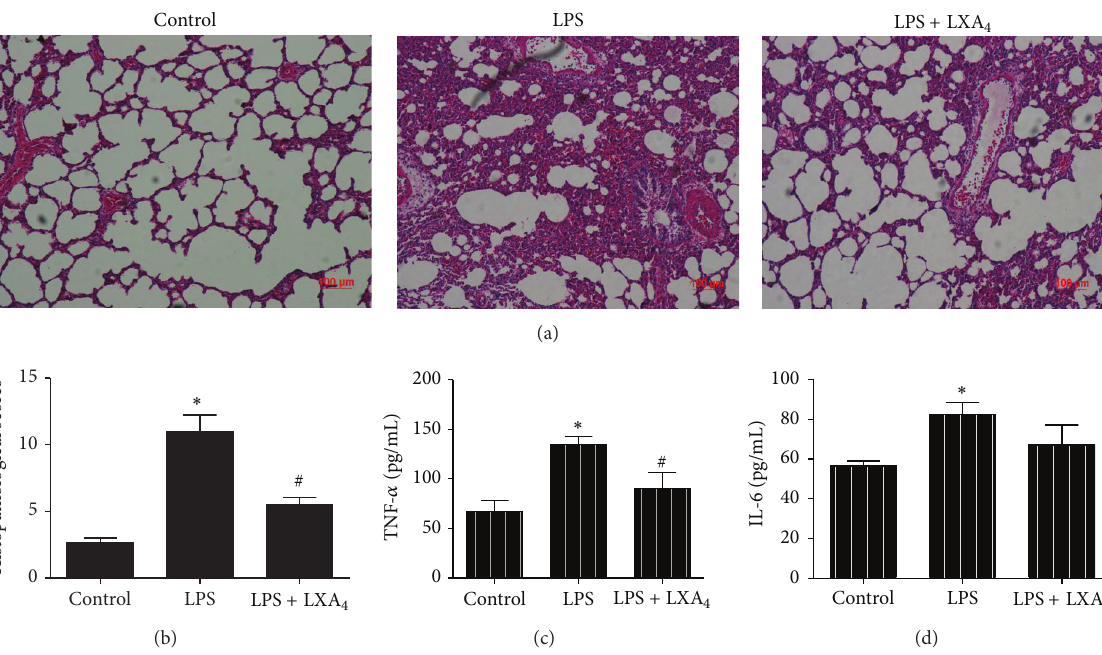
Figure 1: Effects of lipoxin A 4 on LPS-induced ALI. Lipoxin A 4 (2 𝜇 g/kg) was administered intravenously to Sprague-Dawley (SD) rats 6h after LPS (20mL/kg) stimulation through the tail vein, and intratracheal instillation of 5% albumin solution containing Evans Blue-labeled albumin through a tracheostomy to the left lung, and ventilating for 1 hour. The right lung was isolated. The effect of lipoxin A 4 was assessed by (a) histology in hematoxylin and eosin-stained sections, (b) histopathological scores, (c) the lung tissues homogenate TNF- 𝛼 protein expression, and (d) the lung tissues homogenate IL-6 protein expression. Data were expressed as mean ± SEM for each group. ∗ 𝑃 < 0.05 versus control group, # 𝑃 < 0.05 versus LPS group, 𝑛 = 6 for each group. LPS = lipopolysaccharide, LXA 4 = lipoxin A 4 .